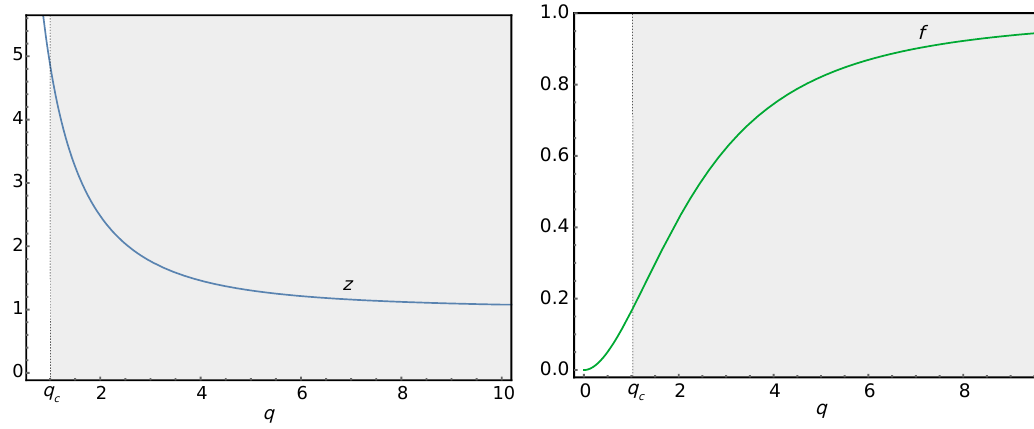
Figure 1 . Left: dynamical critical exponent z as a function of the backreaction parameter q , as given by eq. (4.4). Right: the number of the degrees of freedom f , given by eq. (4.1), as a function of the backreaction parameter q . In both plots, the gray region corresponds to values q > q c for which the Lifshitz solution is